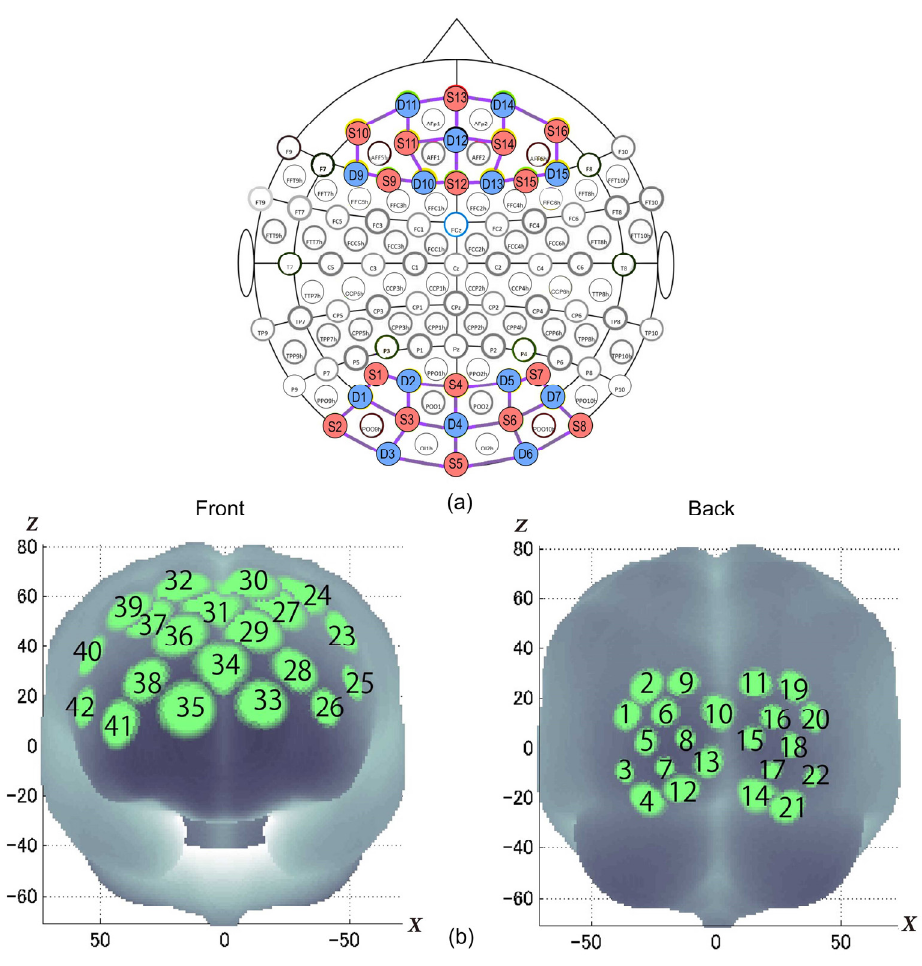
Figure 3. ( a ) Montage map with optodes placement (sources (S) in red and detectors (D) in blue) and ( b ) statistically estimated fNIRS channel locations on the brain for two students, their spatial variability (SDs radii of the light green circles) associated with the estimation exhibited in MNI space. Front and back head views.